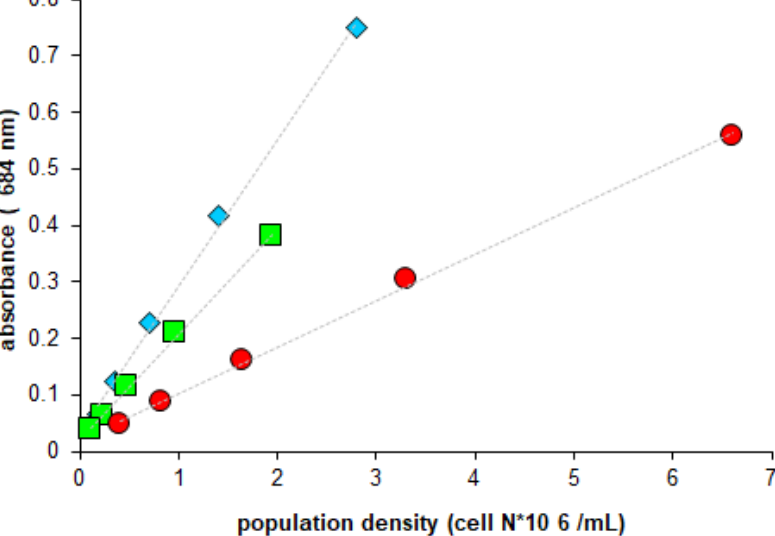
Figure 2. Relationship between target species cell density and light absorbance ( (cid:7) P. tricornutum , (cid:4) D. tertiolecta , • R. subcapitata ). All the regression functions are statistically significant at p < 0.001 with a high explained variance (R 2 Pt = 0.998; R 2 Dt = 0.998; R 2 Rs = 0.998).